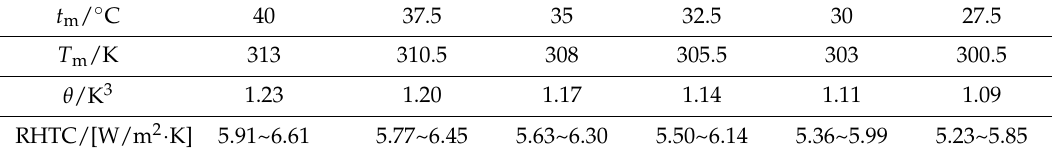
Table 2. Radiation heat transfer coefficients (RHTCs) under different average temperatures. t m / ◦ C 40 37.5 35 32.5 30 27.5 T m /K 313 310.5 308 305.5 303 300.5 θ /K 3 1.23 1.20 1.17 1.14 1.11 1.09 RHTC/[W/m 2 · K] 5.91~6.61 5.77~6.45